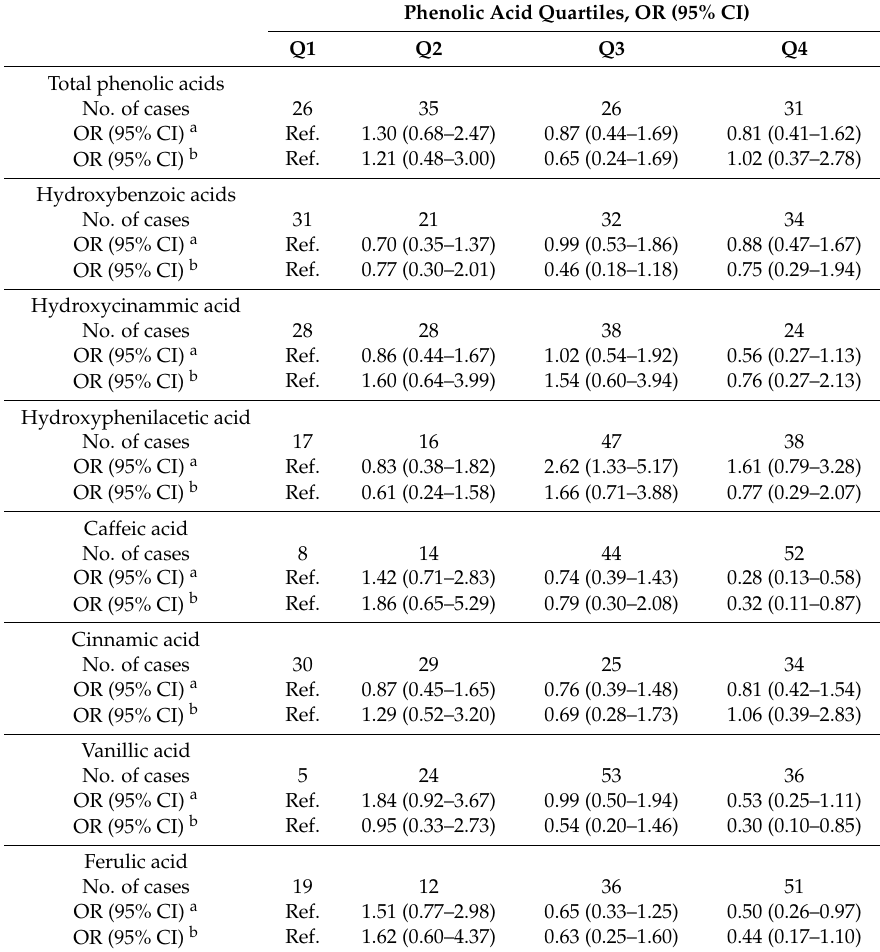
Table 3. Association between quartiles of total, subclasses and individual phenolic acid intake and prostate